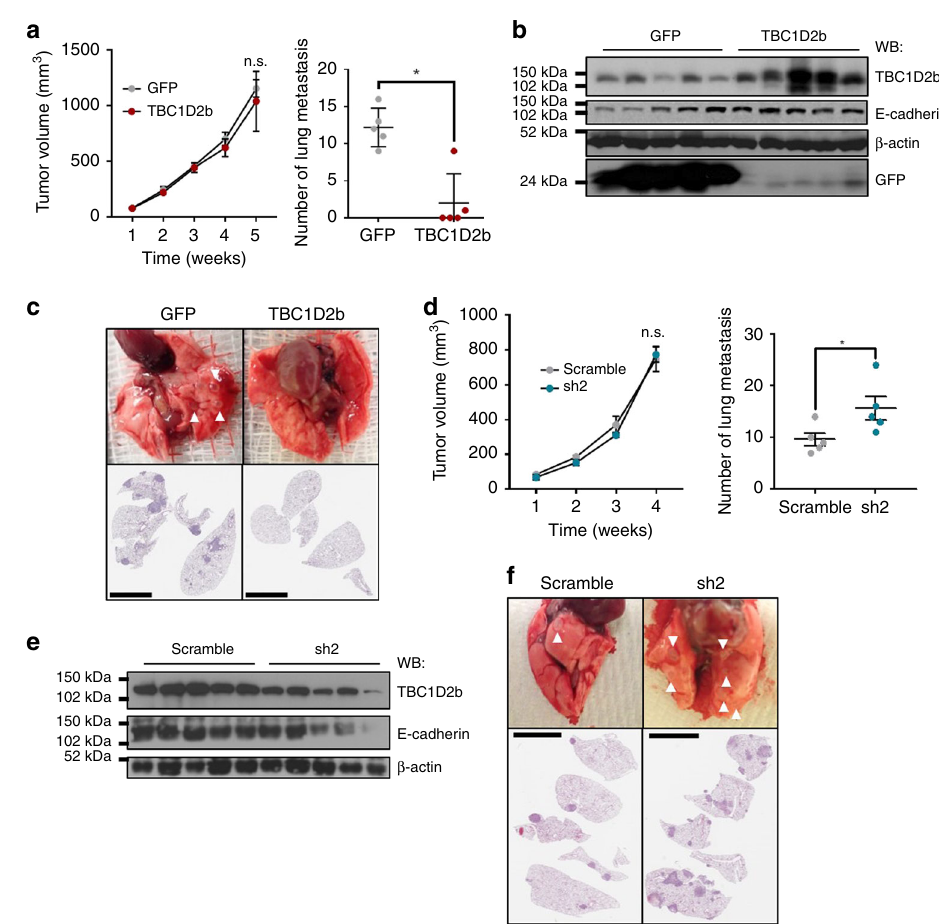
Fig. 7 TBC1D2b overexpression in murine NSCLC cell lines inhibits metastatic potential. a 344SQ GFP control and TBC1D2b expressing cell lines were injected into the fl ank of 129/Sv mice; all asterisks indicate statistical signi fi cance by t -test ( n ≥ 5, * p ≤ 0.05). The tumors were measured weekly and once tumors reached a maximum diameter of 1.5 cm, mice were euthanized. The number of lung metastases in the experimental mice versus the control were quanti fi ed manually. b Overexpression of TBC1D2b was con fi rmed by western blot and correlated with E-cadherin protein expression. c Representative lungs and respective H&E sections are shown. Arrows demonstrate metastatic lesions quanti fi ed. d 344SQ control or shRNA knockdown of TBC1D2b was performed similarly. Upon euthanasia, TBC1D2b (sh2) knockdown group was comparable in size to control (scramble) group; however, number of metastases was signi fi cantly greater in TBC1D2b knockdown group; all asterisks indicate statistical signi fi cance by t -test ( n ≥ 3, * p ≤ 0.05). Scale bars represent 5 mm. e Western blot con fi rms knockdown and downregulation of E-cadherin upon depletion of TBC1D2b. f H&E staining of lung sections and representative lungs from knockdown experiment. Scale bars represents 5